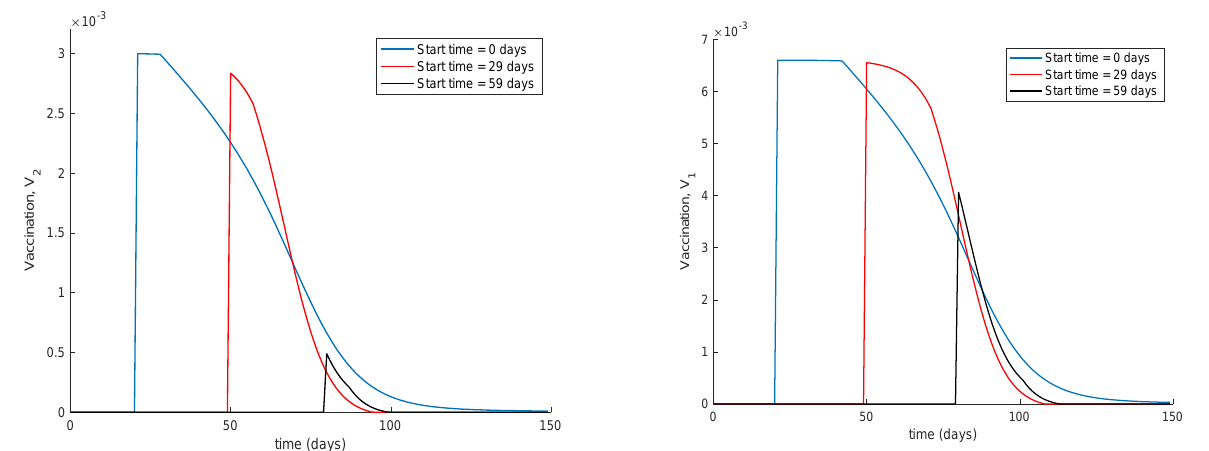
Figure 4. Vaccination actions corresponding to different starting times.